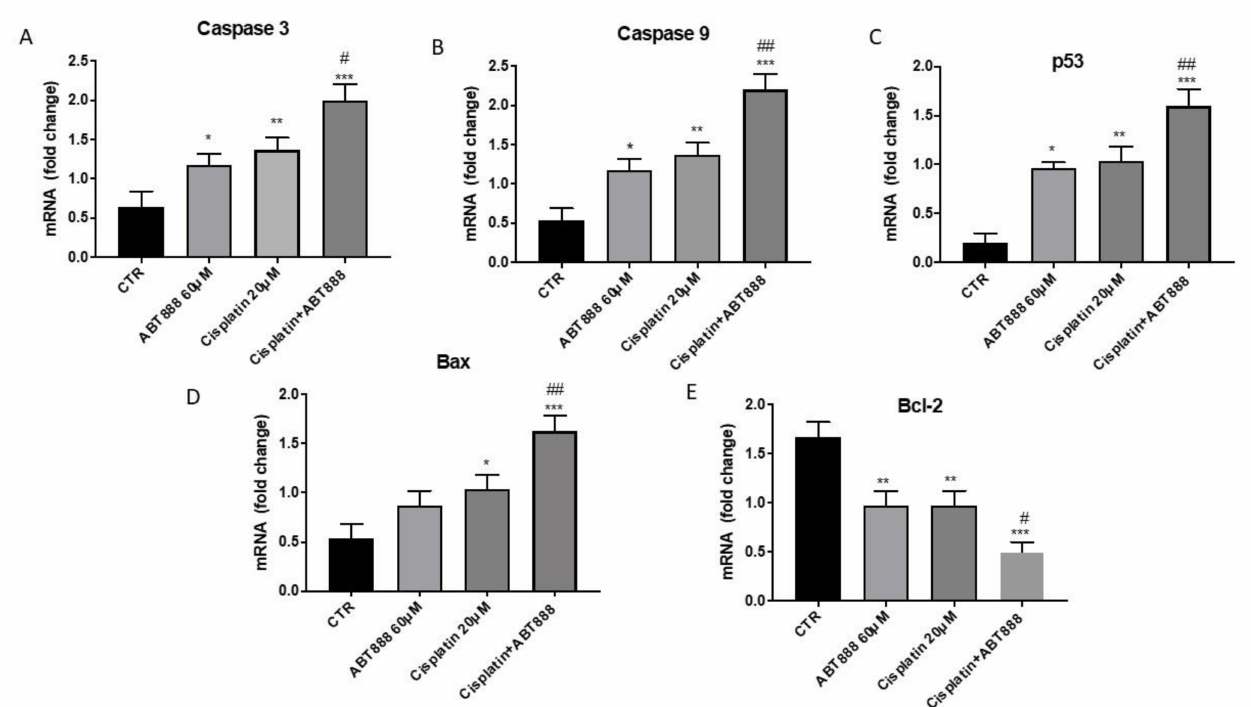
Figure 2. Effect of ABT888 and cisplatin on apoptosis pathway. Treatment with ABT888 and cisplatin increased Bax, caspase-3, caspase-9 and p53 mRNA expression in CAL27 cell line compared to single treatments and control groups, as shown in Figures A, B, C and D, respectively. Bcl2 mRNA expression was significantly reduced in the combinatory treatment as well as in the treatment of ABT888 and cisplatin alone compared to control group ( E ). Data are representative of at least three independent experiments. ( A ) * p < 0.05, ** p < 0.01, *** p < 0.001 vs. the control; # p < 0.05 vs. cisplatin